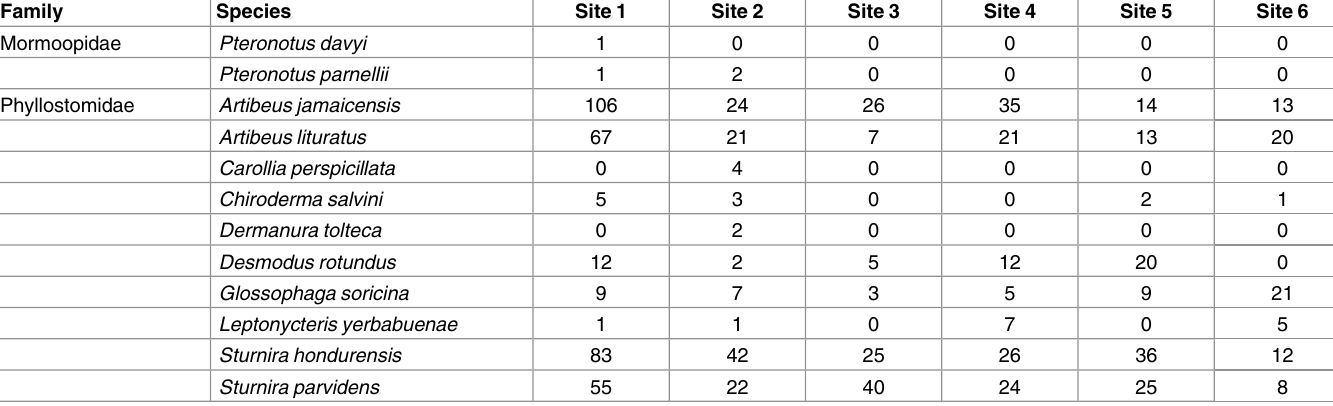
Table 3. List of bat species captured. For each species we includethe total numberof individualsrecorded in each site of the Huasteca regionin the state of Hidalgo,Mexico.